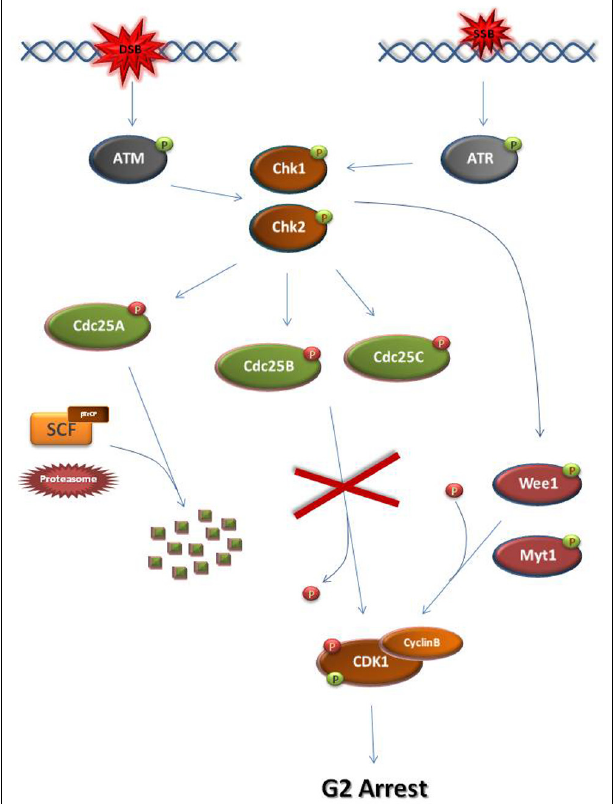
FIGURE 1 | Schematic representation of the major steps of the G1 DNA damage checkpoint. Double strand breaks (DSB) and single strand breaks (SSB) cause the activation of the master DNA damage checkpoint kinases ATM and ATR, respectively. ATM phosphorylates and activates the downstream effector checkpoint kinases Chk1 and Chk2, while ATR activates Chk1. ATM/ATR and the checkpoint kinases activate the transcription factor p53. p53 drives the transcription of the cyclin-dependent kinase (CDK) inhibitor p21. p21 binds and inhibits CDKs responsible for progression into S-phase, such as Cyclin E-CDK2. As a result, the cell cycle arrests at G1.When the DNA damage cannot be repaired, p53 drives the cell to apoptosis through the transcription of pro-apoptotic genes, such as PAX, PUMA, and NOXA. It must be noted that this figure is an oversimplified representation of the pathways enabled in response to DNA damage at G1 phase. : activating phosphate.